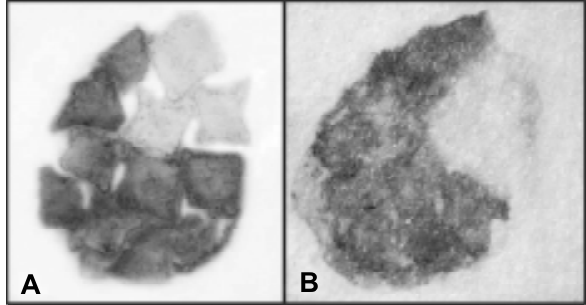
Fig. 3. Detection of Broad bean stain virus by TBIA in a group of 12 infected lentil seedlings, blotted together as one sample on nitrocellulose membrane (A) and on HP non-glossy plotter paper